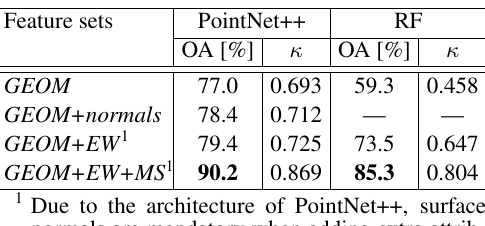
Table 4. Classification results using different data subsets.